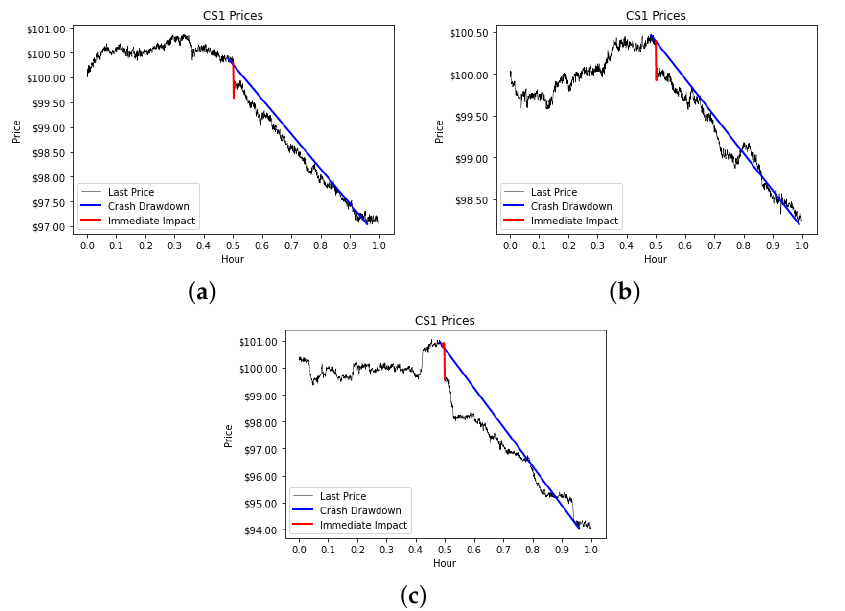
Figure 13. Immediate market impact examples in different market types. In all examples, the trading frequency was 0.5 min, the wealth homogeneity was NH, the stress size was 10%, and the stress traders were 20 S. ( a ) CDA. ( b ) FBA (1.0). ( c )